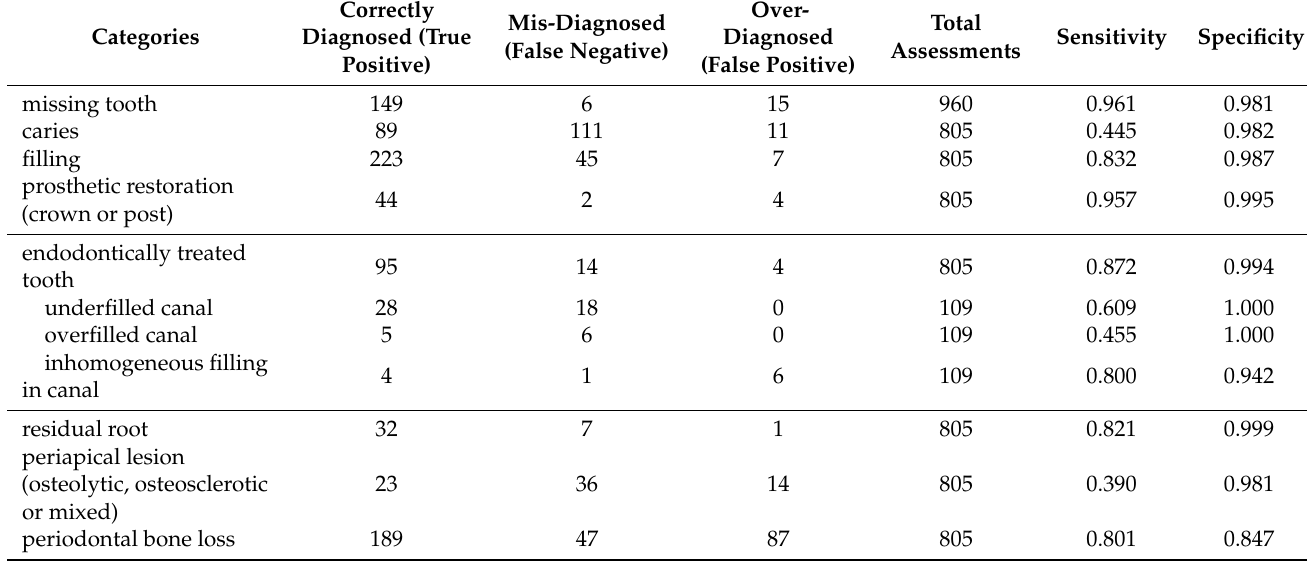
Table 1. Sensitivity and specificity assessment of Diagnocat software.